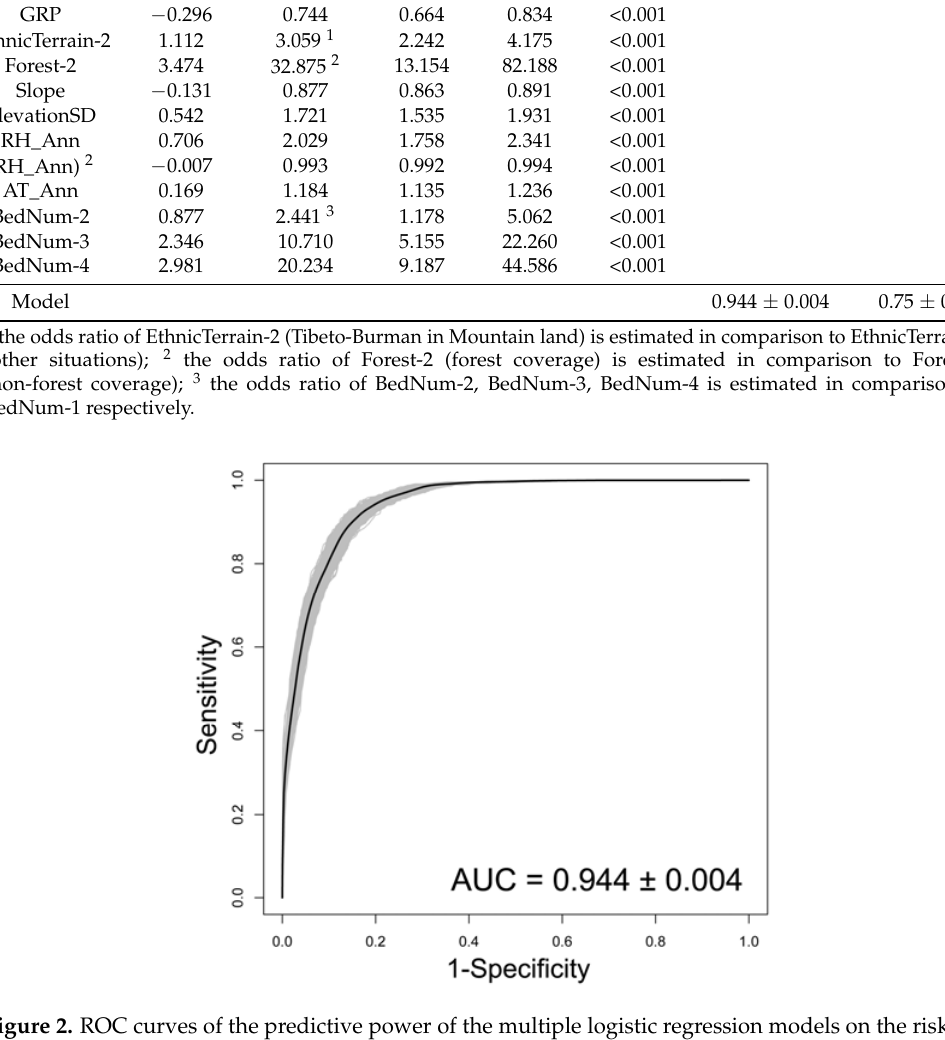
Table 3. Summary of the multiple logistic regression models on the risks for bacillary dysentery in southwest China.